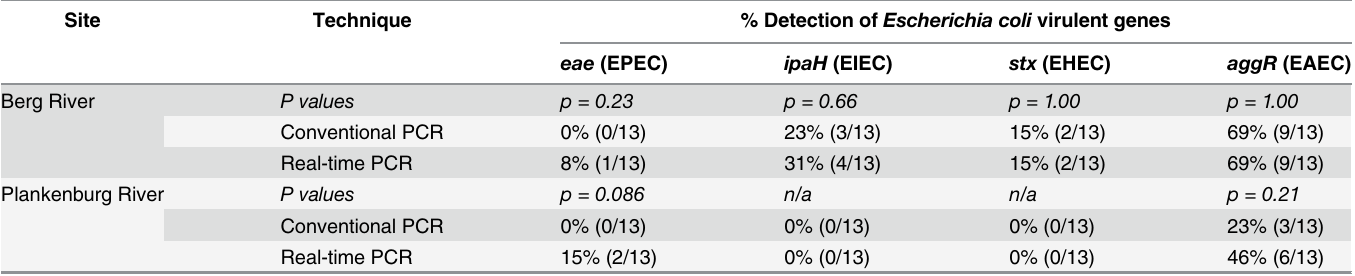
Table 2. Pearson Chi-square observed frequency for E . coli virulent genes in the Berg and Plankenburg River systems using the Conventional- and Real-time PCR assays.